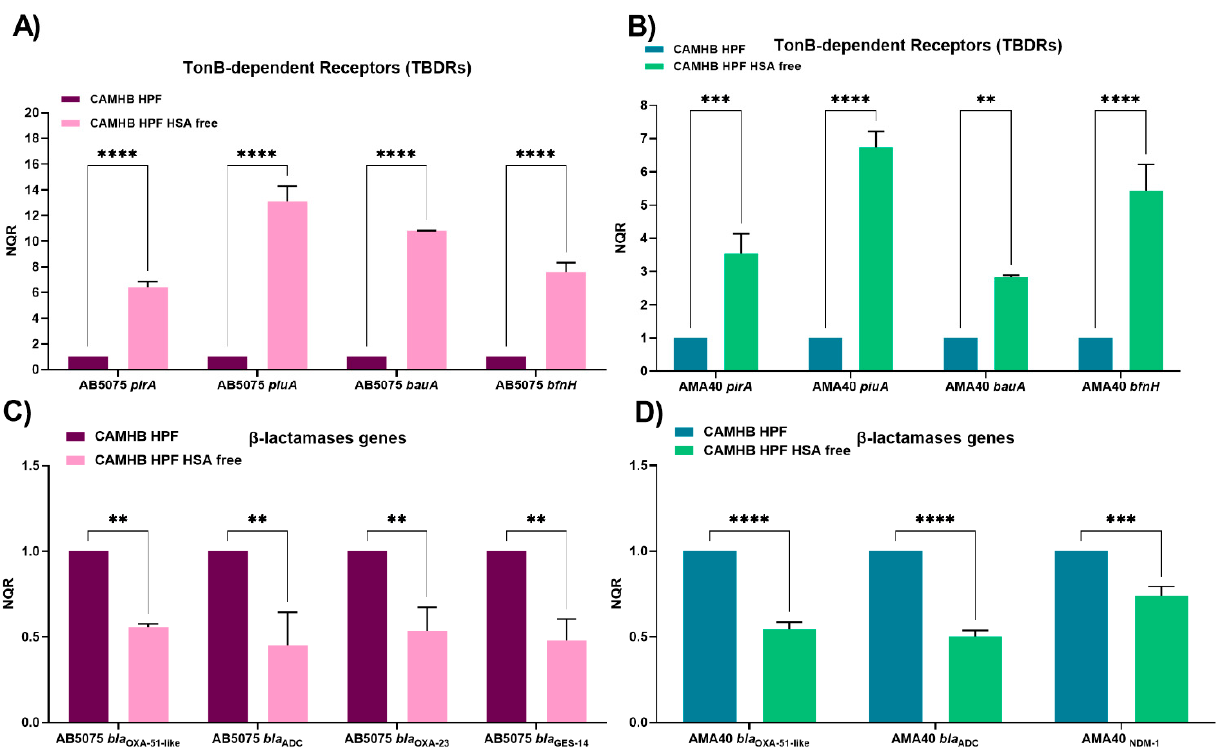
Figure 2. Expression analysis of iron uptake genes and genes coding for β -lactamases in the AB5075 ( A , C ) and AMA40 ( B , D ) strains. The qRT-PCR of TonB-dependent receptors ( pirA, piuA, bauA, and bfnH ) and bla genes ( bla OXA-51-like , bla ADC , bla OXA-23 , bla NDM-1 , and bla GES-11 ) genes expressed in cation-adjusted Mueller Hinton (CAMHB) supplemented with either human pleural fluid (HPF) or HSA-free HPF. The data shown are the means ± SD of normalized relative quantities (NRQ) obtained from transcript levels calculated via the qBASE method. This method is a modification of the classic ∆∆ Ct method to take multiple reference genes (in this work, rpoB and recA ) and gene-specific amplification efficiencies into account. At least three independent samples were used, and four technical replicates were performed from each sample. The CAMHB HPF was used as reference. Statistical significance ( p < 0.05) was determined by two-way ANOVA followed by Tukey’s multiple comparison test, two asterisks: p < 0.01; three asterisks: p < 0.001; and four asterisks: p < 0.0001.